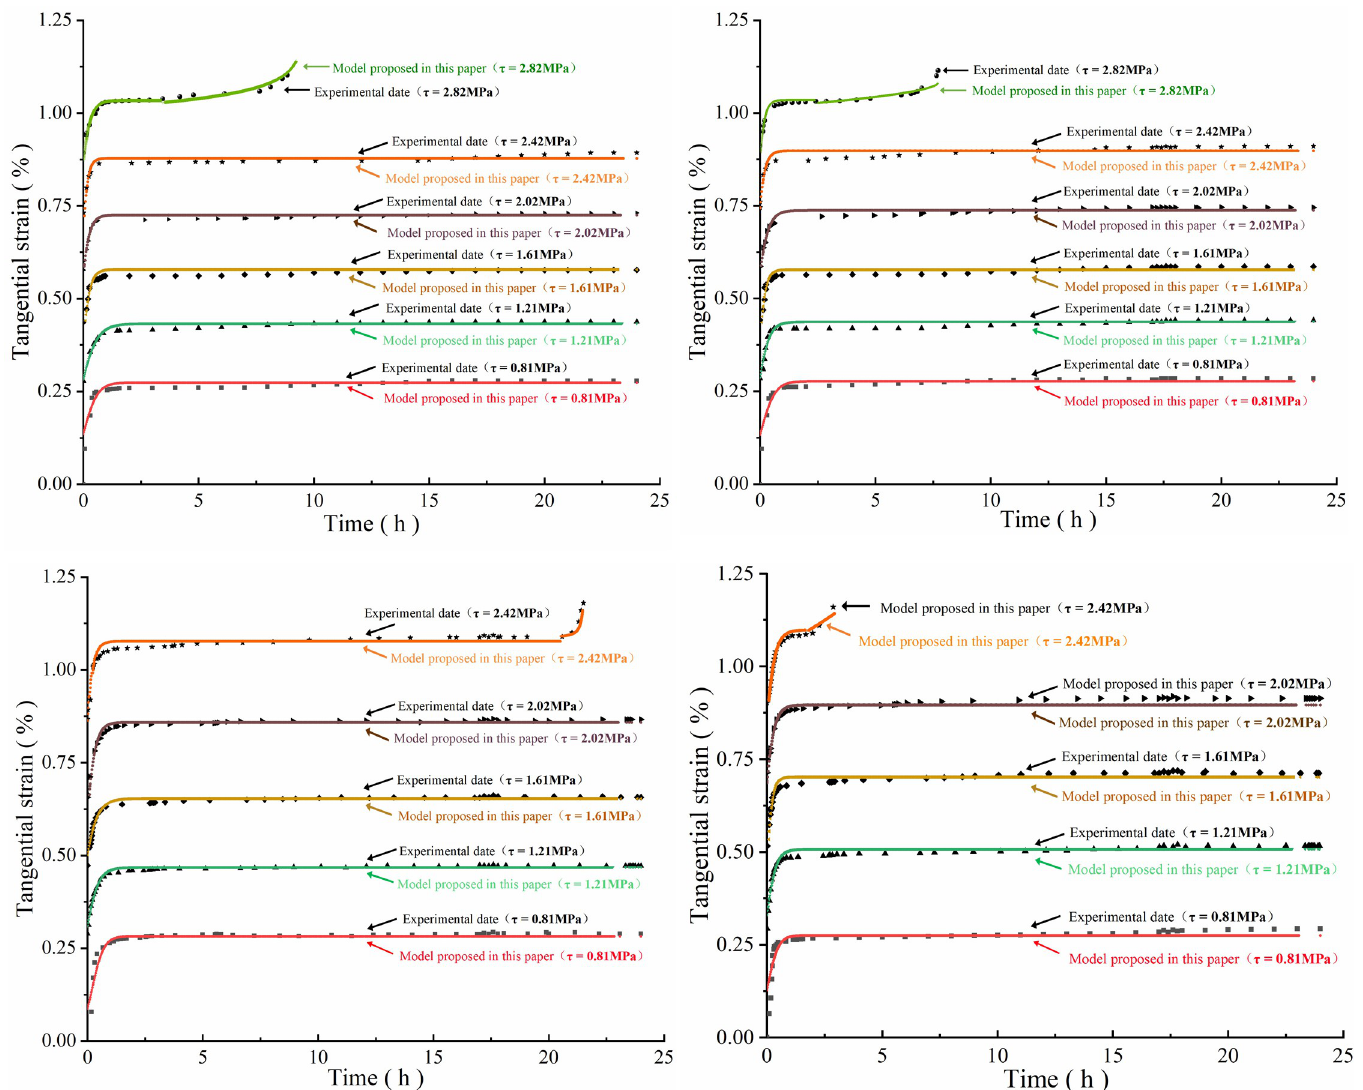
Fig 7. Comparison between model calculations and test curve (a) Comparison between model calculations and test curve of sample A 1 (axial pressure 1 MPa, impact energy 0 J); (b) Comparison between model calculations and test curve of sample A 2 (axial pressure 1 MPa, impact energy 1.34 J); (c) Comparison between model calculations and test curve of sample A 3 (axial pressure 1 MPa, impact energy 2.36 J); (d) Comparison between model calculations and test curve of sample A 4 (axial pressure 1 MPa, impact energy 3.67 J).